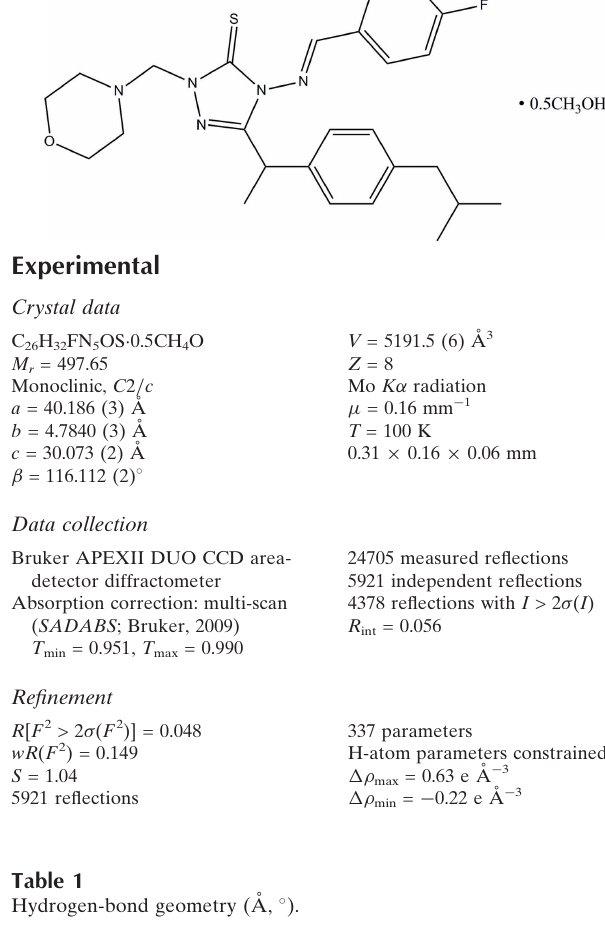
Hydrogen-bond geometry (A˚ , (cid:3)